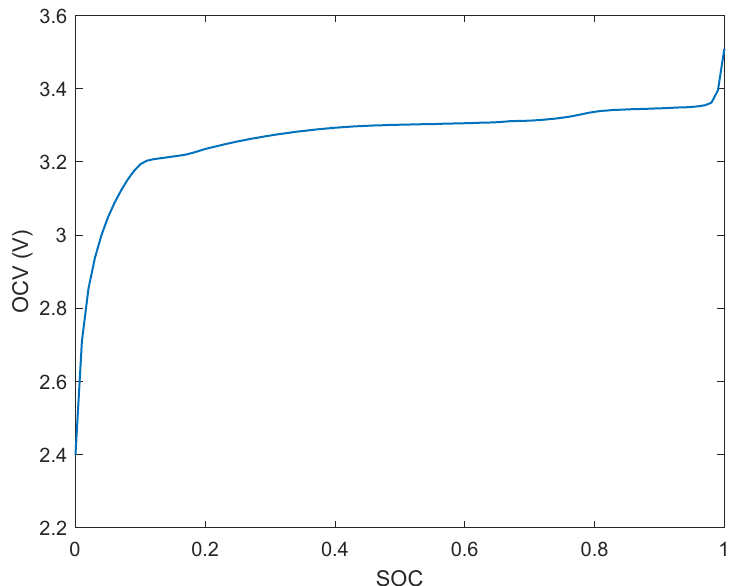
Figure 3. Experimentally established SOC–OCV curve of the LFP cells.